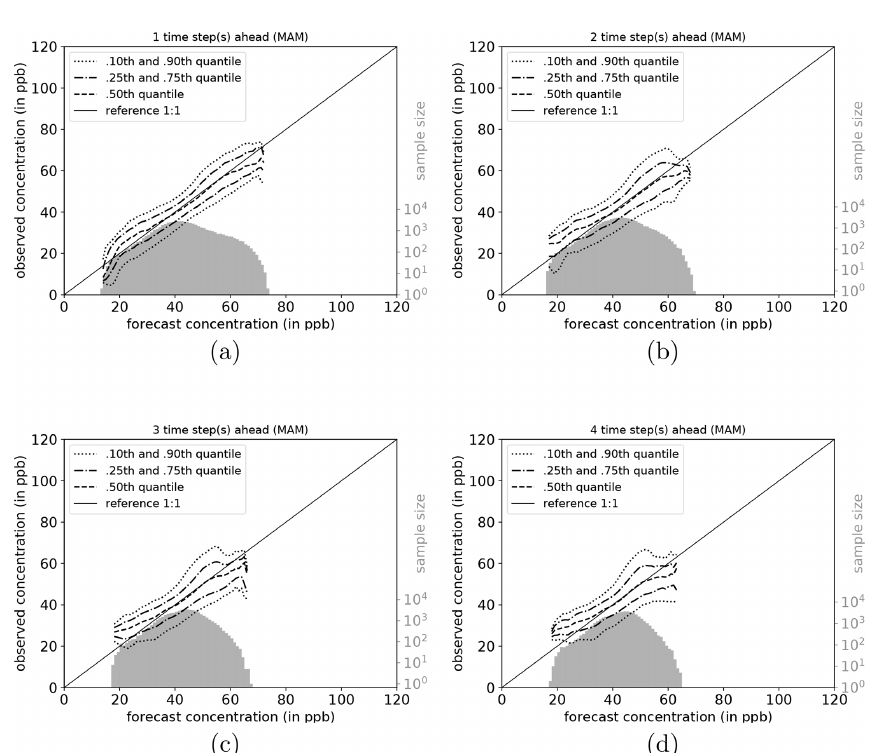
Figure A5. Same as Fig. 6 but for